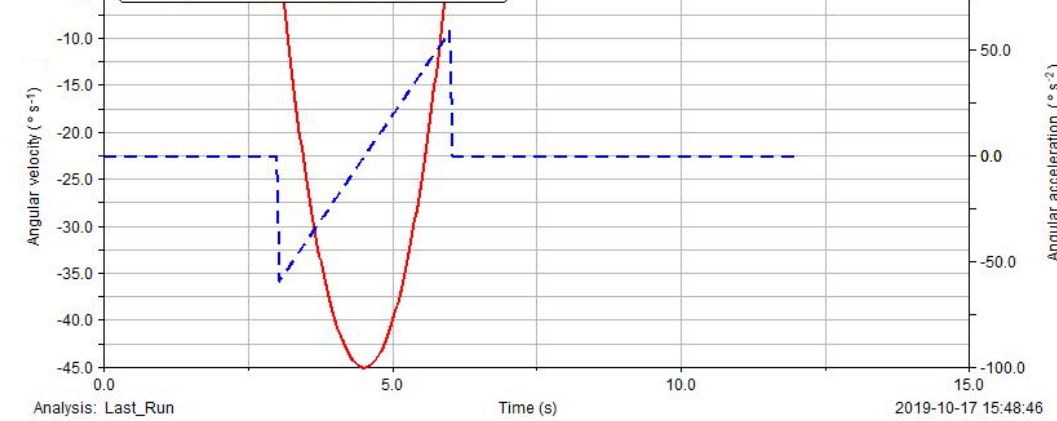
Figure 19. Simulation curve of robot rotation.